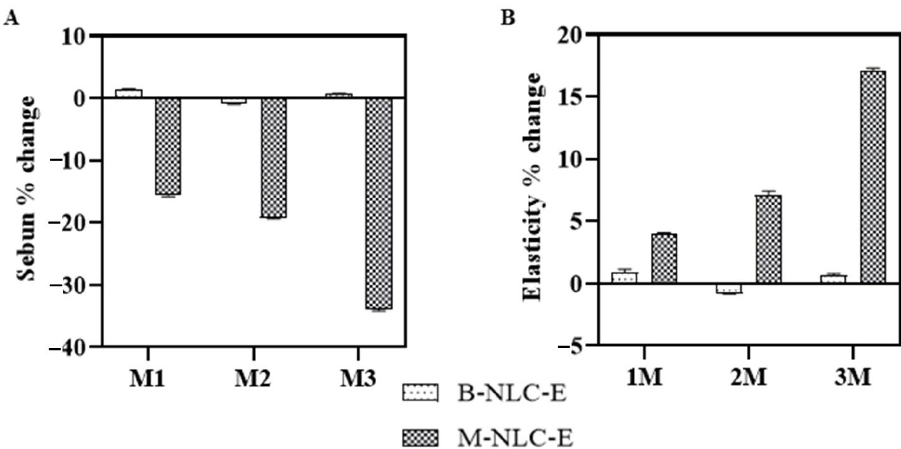
Figure 14. Analyses of skin sebum ( A ) and elasticity ( B ) after 1st (M1), 2nd (M2) and 3rd month (M3) of use of B-NLC-E and M-NLC-E.